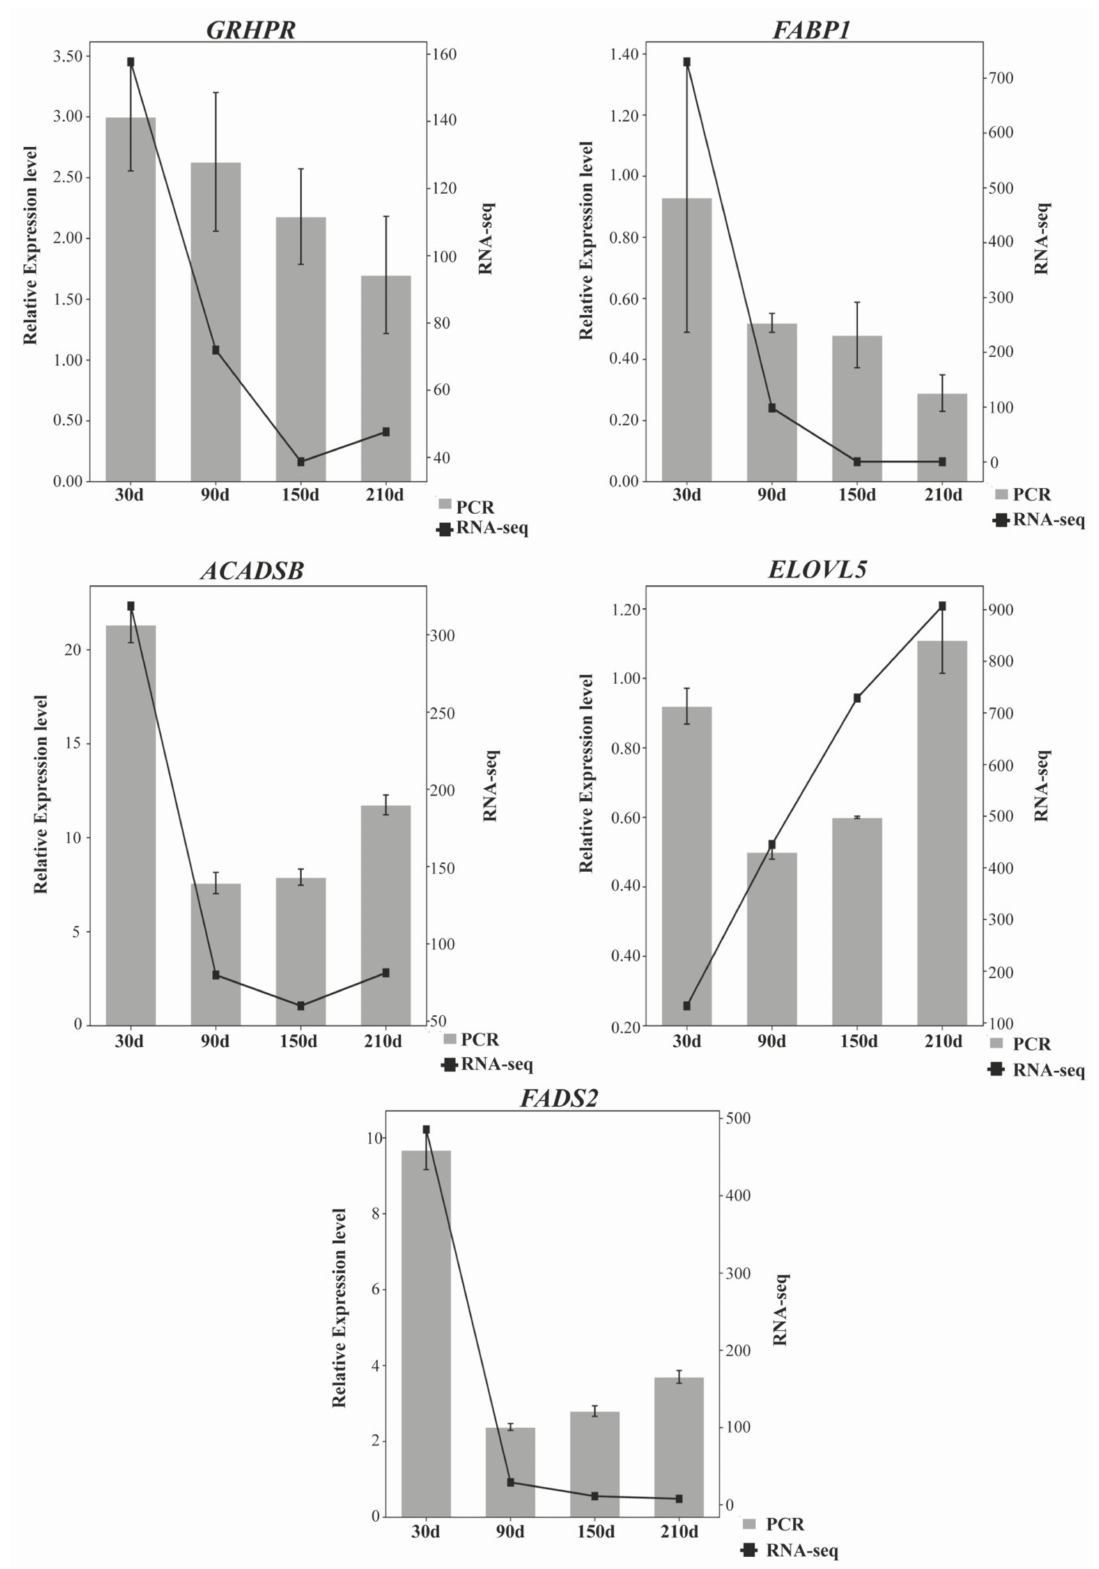
Figure 7. Transcription patterns of GRHPR , FABP1 , ACADSB , ELOVL5 , FADS2 compared to expression patterns in the